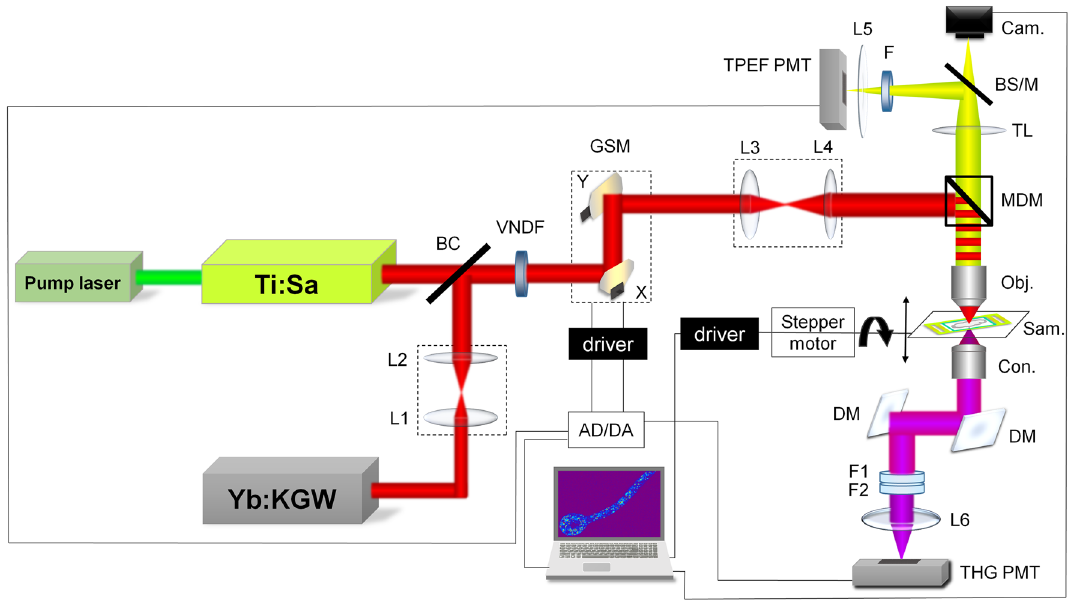
Figure 2. NLSM setup. Ti:Sa—laser for TPEF imaging, Yb:KGW—laser for TPEF and THG imaging, BC— beam combiner, L1 and L2—lenses of 1:1 beam expander for recollimation, VNDF—variable neutral density filter, GSM—galvanometer-scanning mirrors, L3 and L4—lenses of 1:3.75 beam expander for imaging, MDM— main dichroic mirror (cut-off 700 nm), Obj.—microscopic objective 40 × 1.3, Sam.—sample, Con.—aspheric condenser lens, DM—dichroic mirrors reflective for THG (347 nm) and transmissive for Yb laser (1040 nm), F1—Hoya glass UV filter, peak transmission 340 nm, F2—bandpass filter 275–375 nm, L6—focusing lens, THG PMT—photomultiplier tube for THG signal, TL—tube lens, BS/M—beam splitter or mirror toggle, Cam.— camera, F—VIS filter 400–700 nm for autofluorescence or VIS + 570 nm long pass for Nile Red fluorescence, L5—focusing lens, TPEF PMT—photomultiplier tube for TPEF signal, AD/DA—acquisition card. The scheme was created in Microsoft Power Point 2016 (https:// www. micro soft. com/ en- us/ micro soft- 365/ power